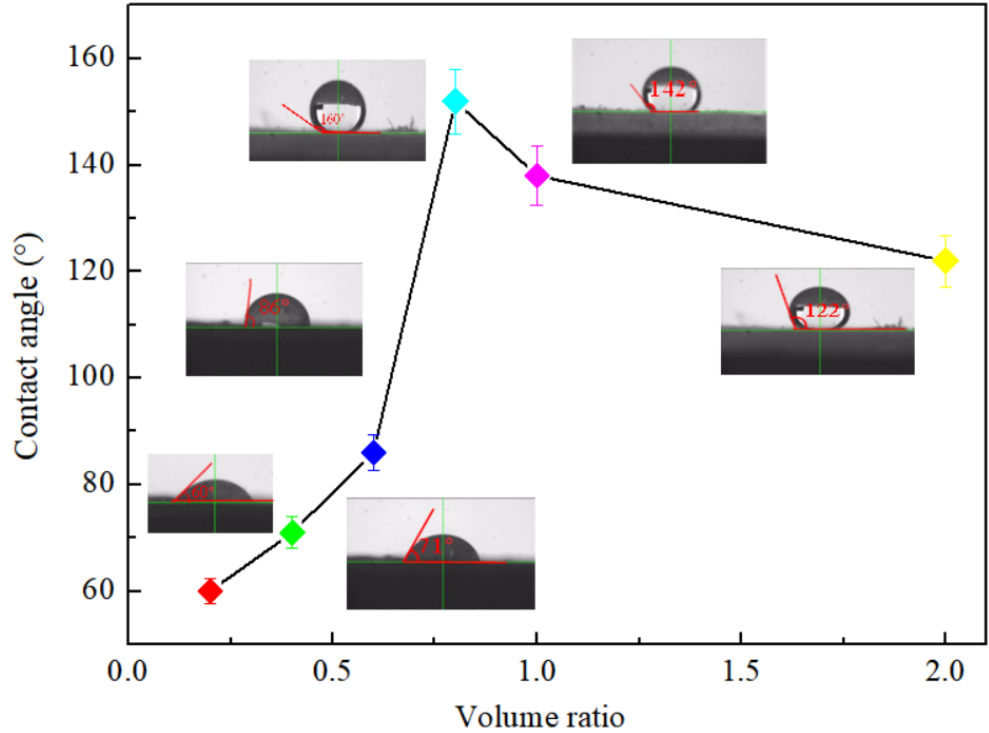
Figure 3. Contact angles onto the VF-SiO 2 aerogel surfaces.